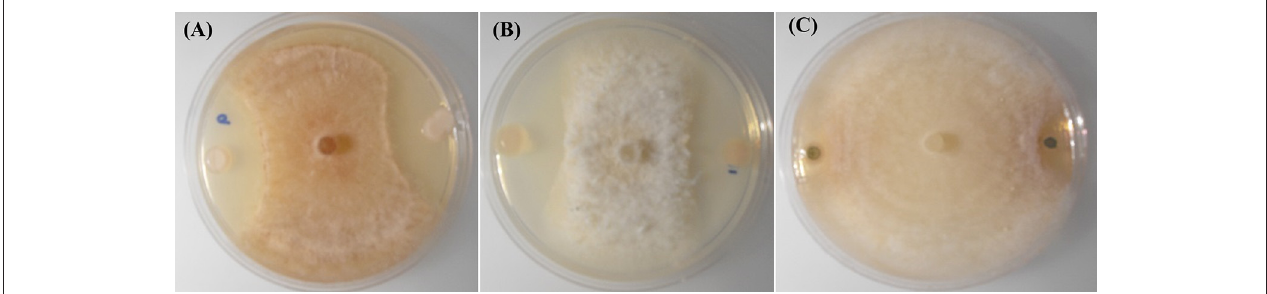
FIGURE 1 | In-vitro inhibition of R. solani AG-8 (Plate A), and Ggt (Plate B ) by poplar endophytes; WP40 and WP42 respectively; with reference to inhibition of Ggt by the positive control strain, Pf 2-79 (Plate C